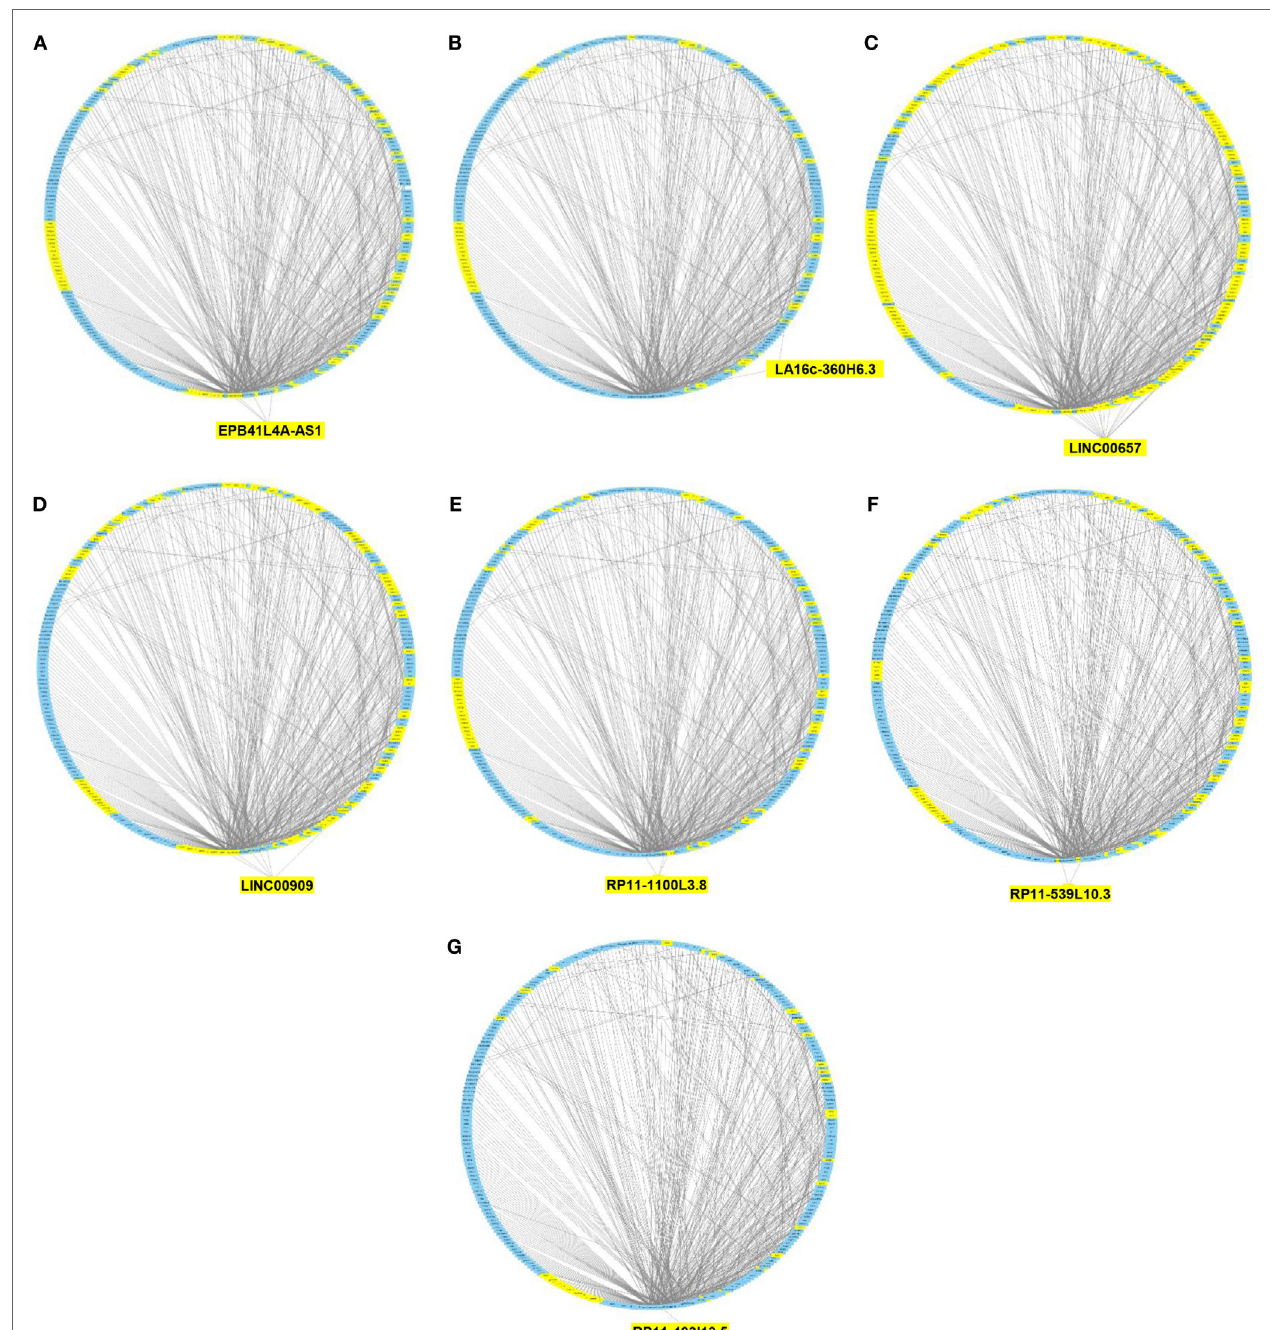
FigUre 3 | Protein–protein interaction (PPI) network of differently expressed genes targeted by selected microRNAs and long non-coding RNAs (lncRNAs). Graphical representation of the connections among genes in the PPI network and EPB41L4A-AS1 (a) , LA16c-360H6.3 (B) , LINC00657 (c) , LINC00909 (D)